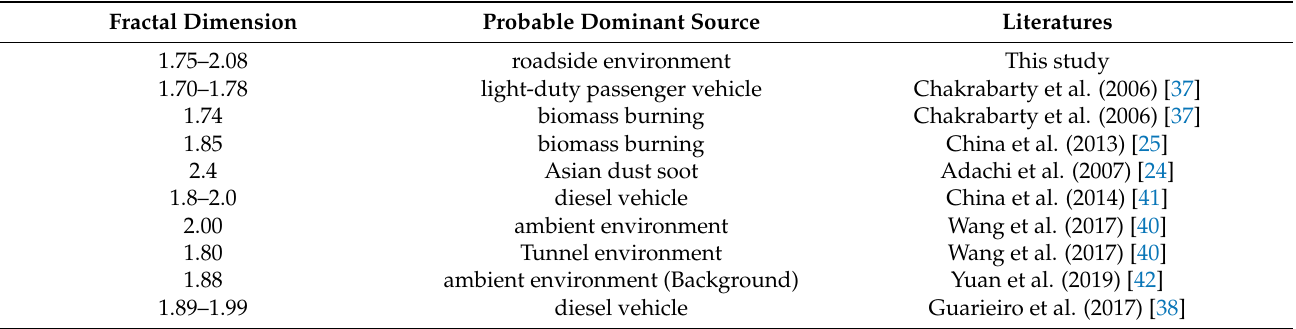
Figure 7. Fractal dimension of soot particles at the roadside site under clear and hazy conditions. The parameter n in parentheses represents the total number of soot particles analyzed to calculate D f . The number of soot particles is from all the samples for each case. Table 2. Mean values of fractal dimension of soot particles from different sources and in the ambient environment.